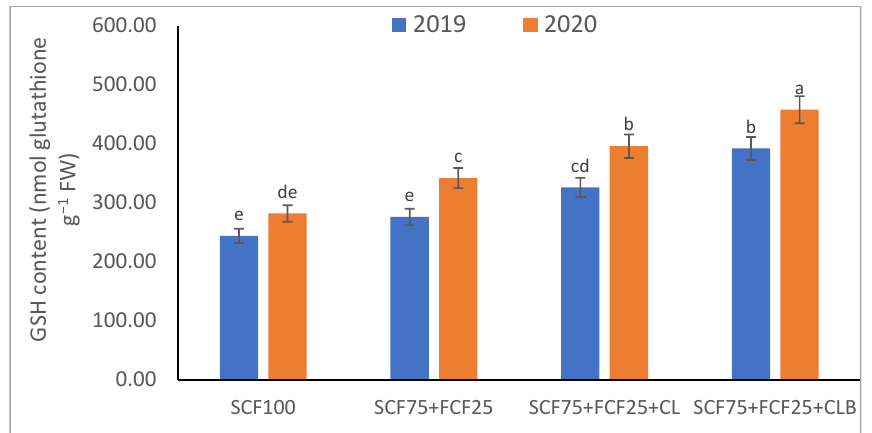
Figure 7. Response of leaf nonenzymatic antioxidants contents (ascorbic acid—AsA) of Phaseolus vulgaris plants to different fertilization strategies applied in two seasons (2019 and 2020) to sandy soil. Abbreviations of fertilization treatments are explained in Table 1. Bars with a different letter indicate significant difference between treatments at p ≤ 0.05.